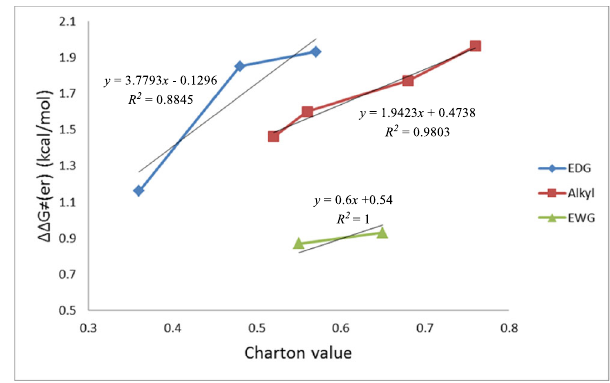
Fig. 7 Correlation of the representative substrate parameters to